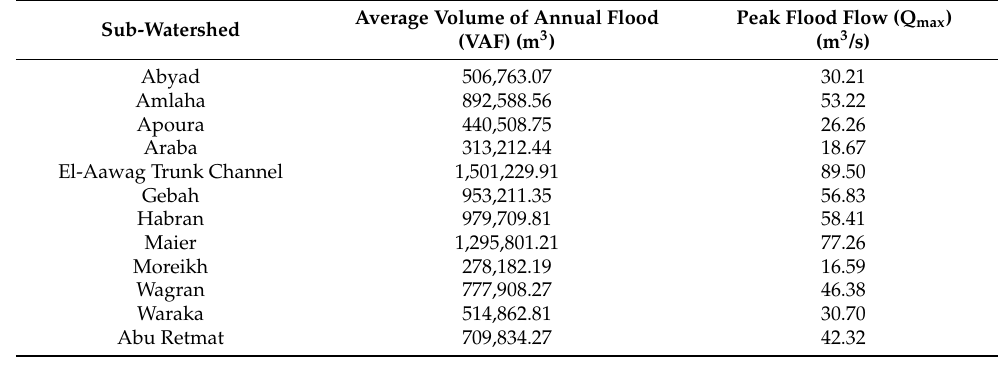
Table 4. The annual flood volume of W. El-Aawag sub-watersheds.